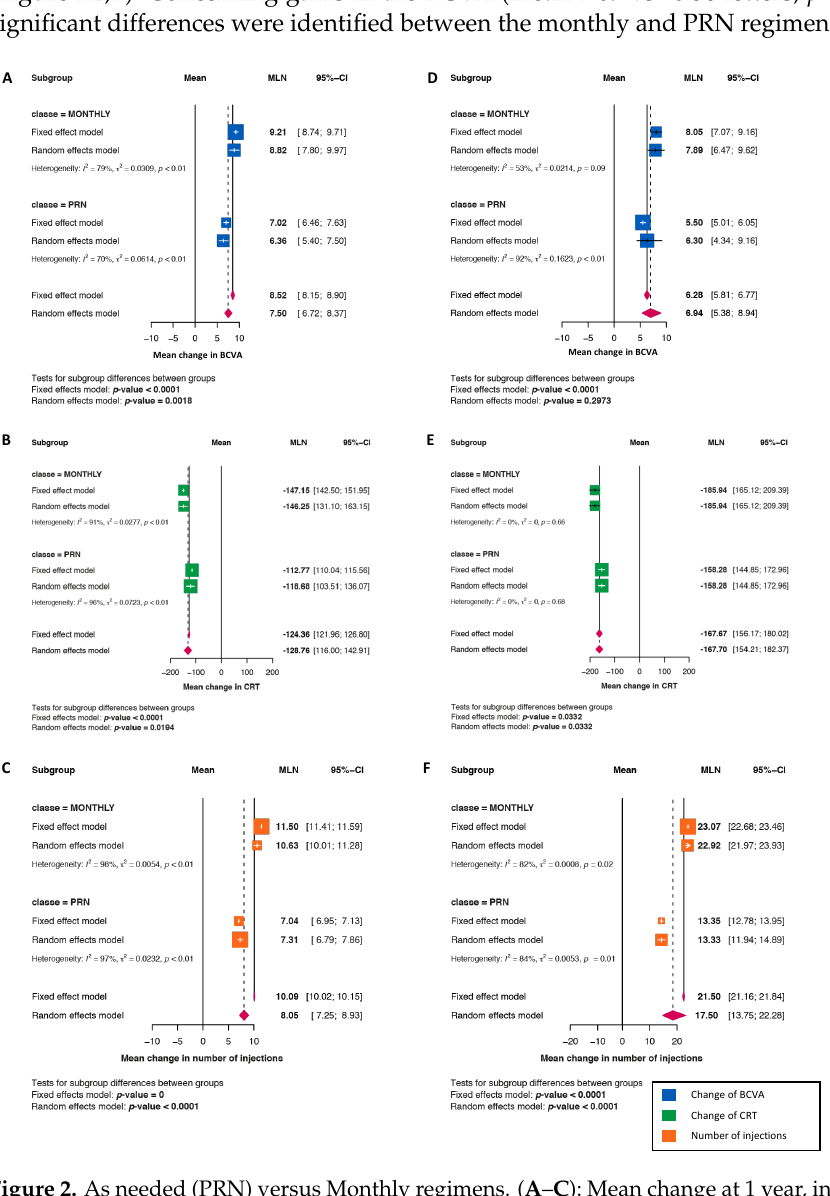
Figure 2. As needed (PRN) versus Monthly regimens. ( A – C ): Mean change at 1 year, in best corrected visual acuity (( A ), blue squares), in CRT (( B ), green squares) and in the number of injections (( C ), orange squares). ( D – F ): Mean change at 2 years, in best corrected visual acuity (( D ), blue squares), in CRT (( E ), green squares) and in the number of injections (( F ), orange